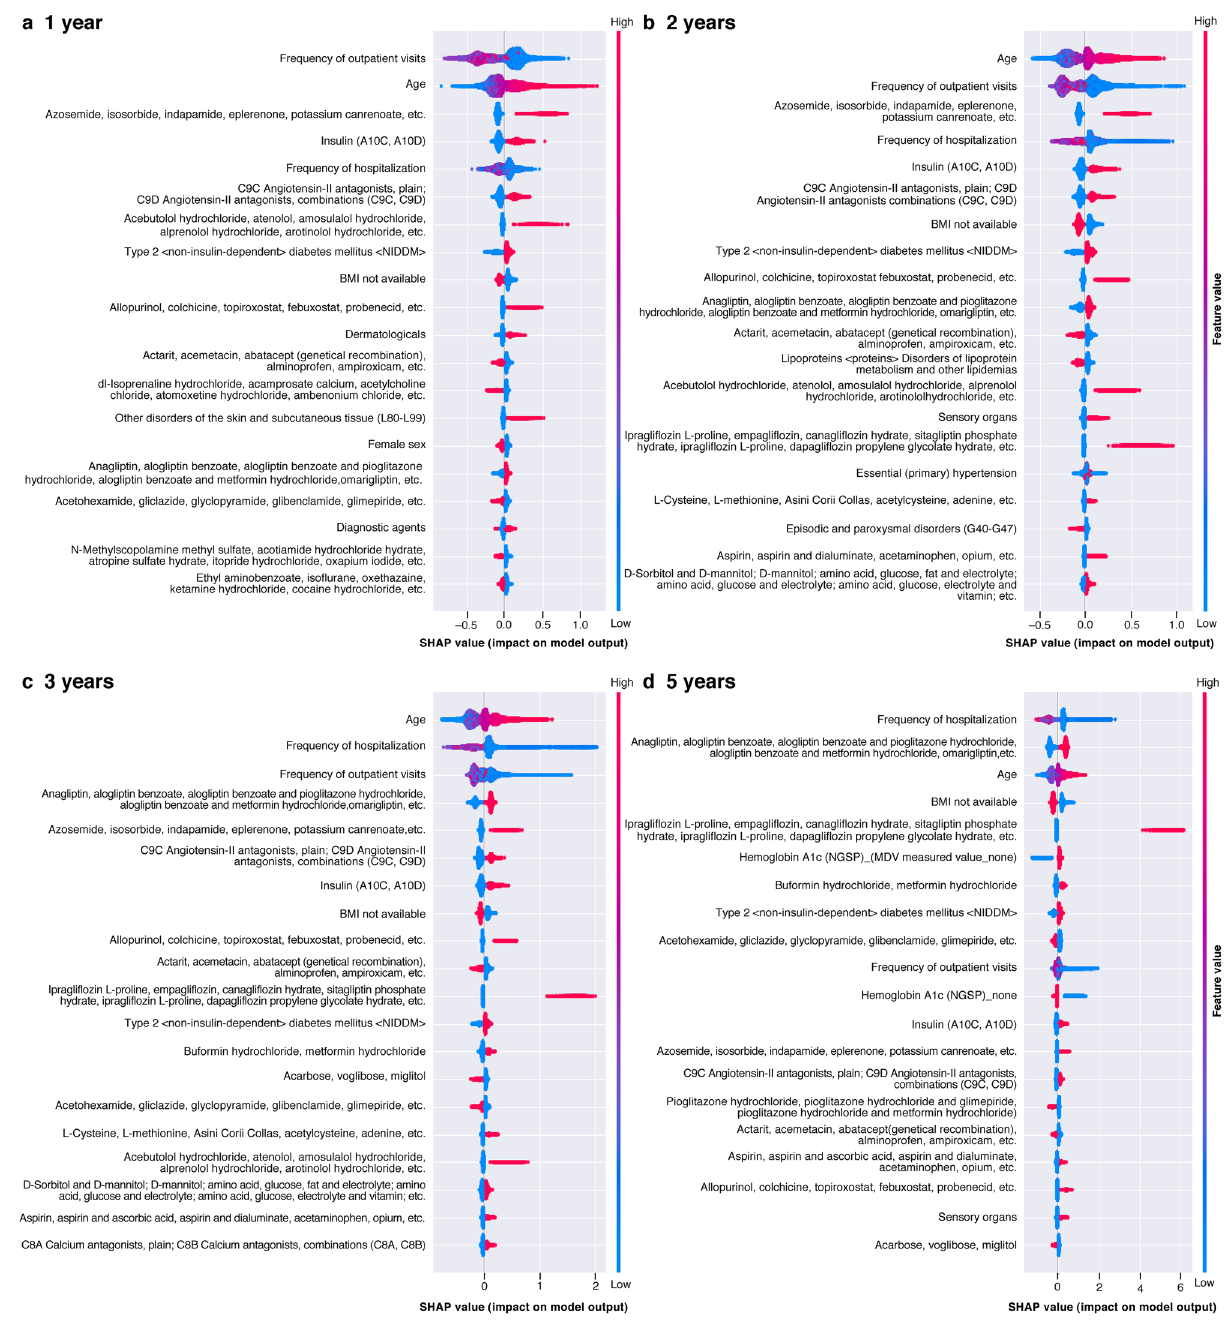
Figure 4. SHAP summary plot in XGB model with 60 variables and 16 laboratory values. ( a )–( d ) Diagnosis of CKD/HF. BMI body mass index, CKD chronic kidney disease, HF heart failure, NGSP National Glycohemoglobin Standardization Program, SHAP SHapley Additive